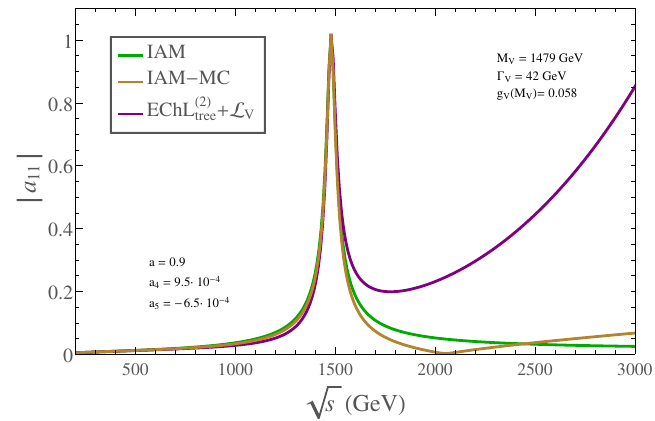
Figure 5 . Prediction of the three models explained in the text: IAM (green), IAM-MC (orange) and g V (purple). The values of the parameters are those of BP1’ in table